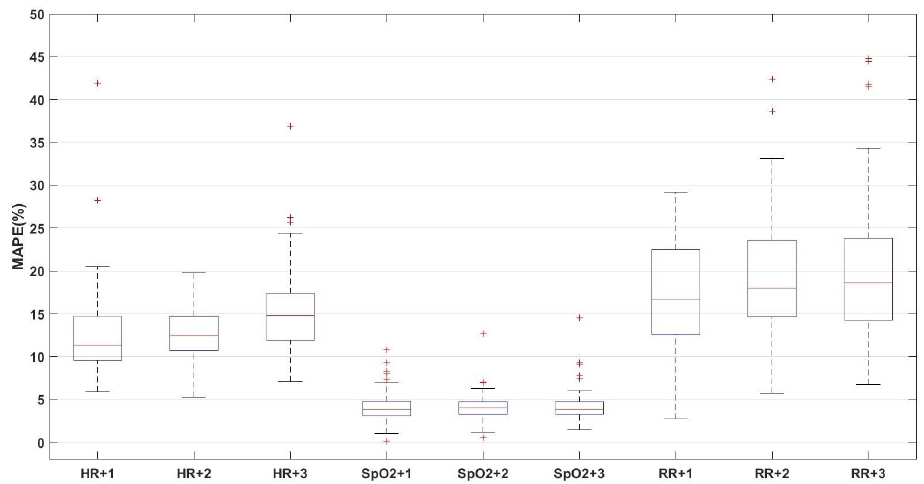
Figure 6. The box-plot of the leave-one-subject-out prediction of the vital signs of heart rate (HR), oxygen saturation (SpO 2 ), and respiration rate (RR) for the upcoming three observations (on average 3 h ahead).